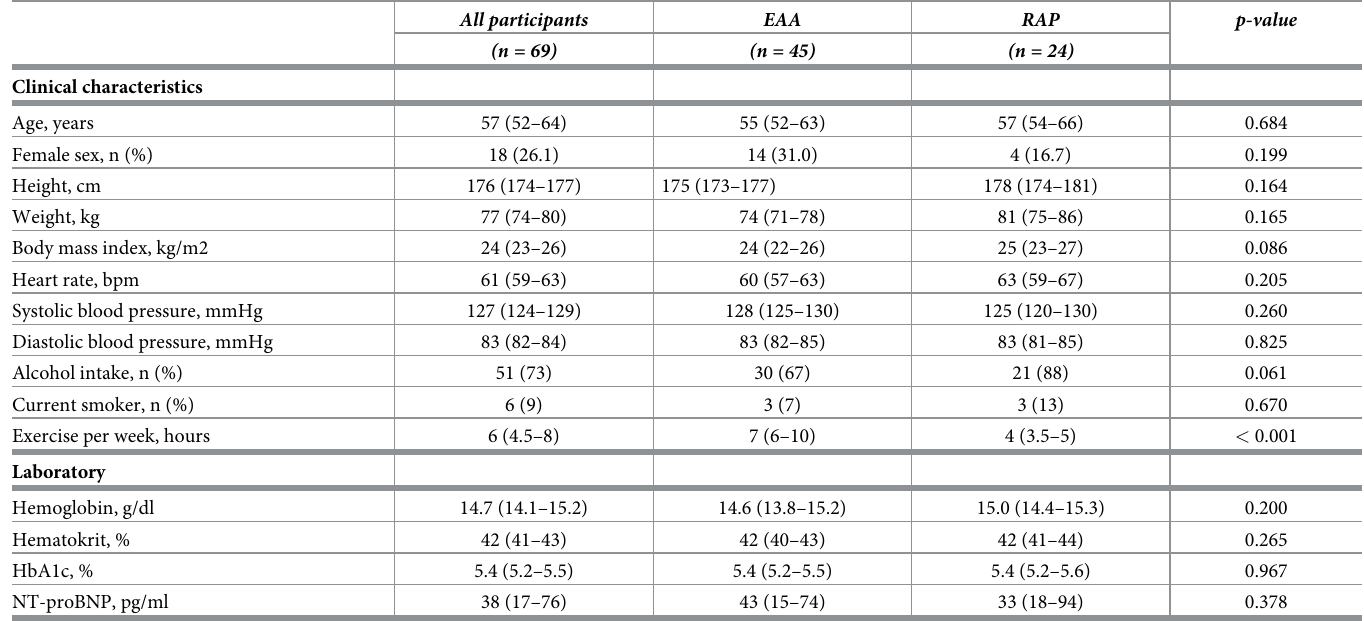
Table 1. Baseline